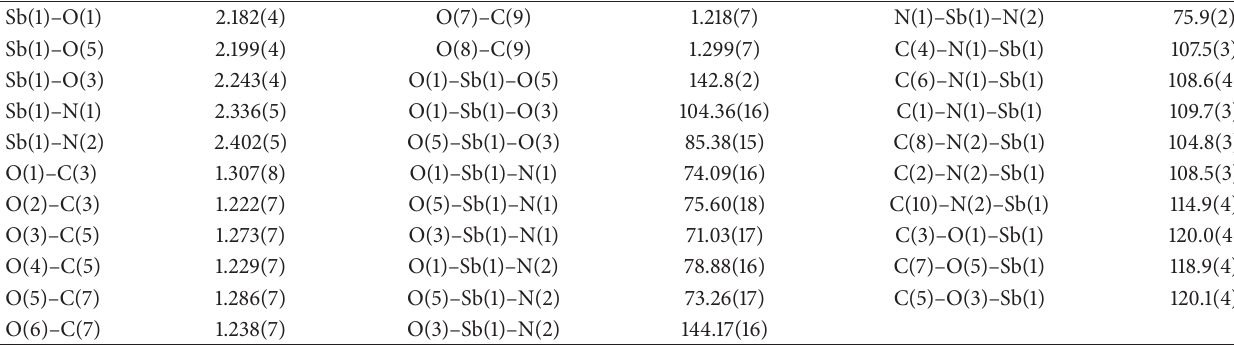
Table 2: Selected bond lengths (˚A) and angles ( ∘ ) for the title complex.